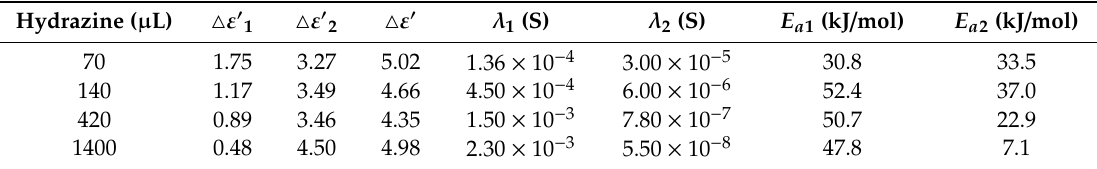
Figure 5. Permittivity spectra of electrorheological fluids (ERFs) of PEANI / rGO obtained by reduction with di ff erent amounts of hydrazine at 25 ◦ C: ( A ) real part ε (cid:48) , ( B ) imaginary part ε ”.